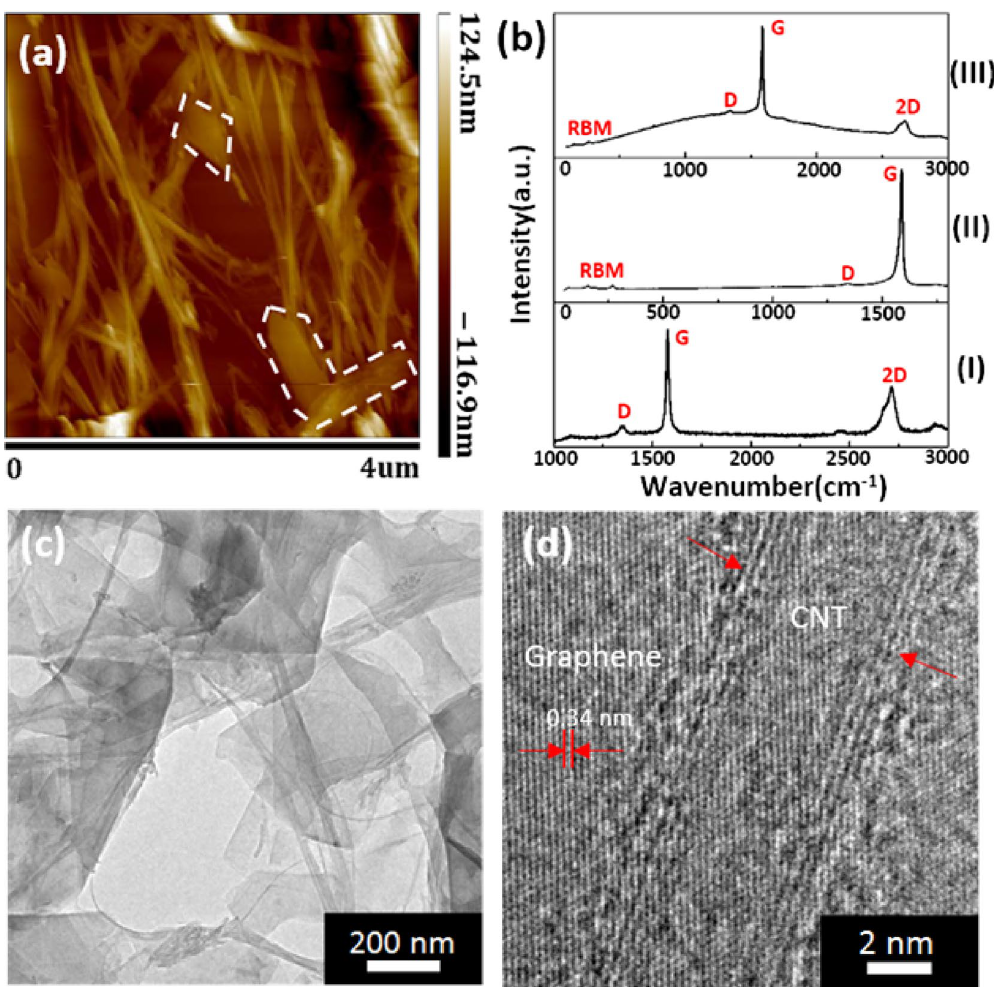
Figure 3. ( a ) Tapping mode AFM images of the GNP-CNT hybrid acquired in a liquid cell. ( b ) Raman image of multi-layer graphene ( b I ), single-walled carbon nanotubes ( b II ), and GNP-CNT hybrid materials ( b III ), respectively. ( c ) and ( d ) TEM and HRTEM images of the GNP-CNT hybrid, respectively. The whiter boxes in ( a ) mark the locations of multi-layer